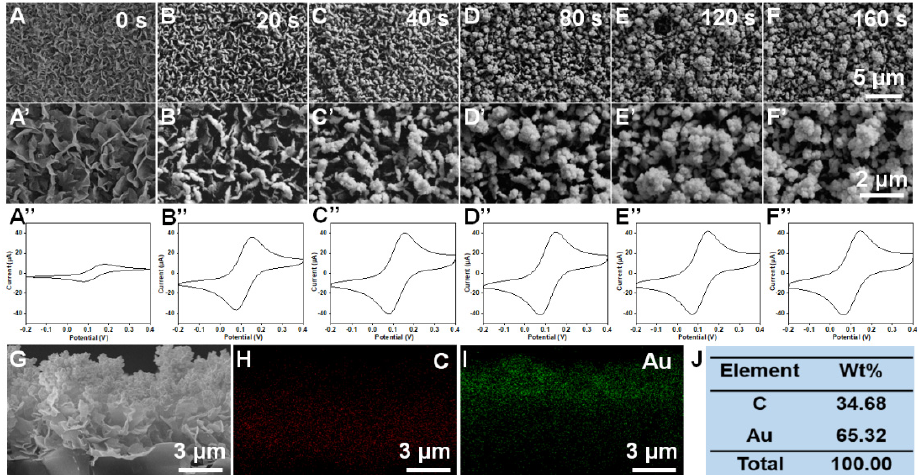
Figure 2. Effect of deposition time on the morphology and electrochemical performance of VG@Au. SEM images of VGs modified with nano Au at different deposition time ( A , A’ ) 0 s; ( B , B’ ) 20 s; ( C , C’ ) 40 s; ( D , D’ ) 80 s; ( E , E’ ) 120 s; ( F , F’ ) 160 s. ( A” – F” ) are the corresponding CV curves of figure ( A – F ). The cross-section view morphology ( G ) and corresponding element distribution characterization ( H − J ) of VG@Au at deposition time of 80 s.